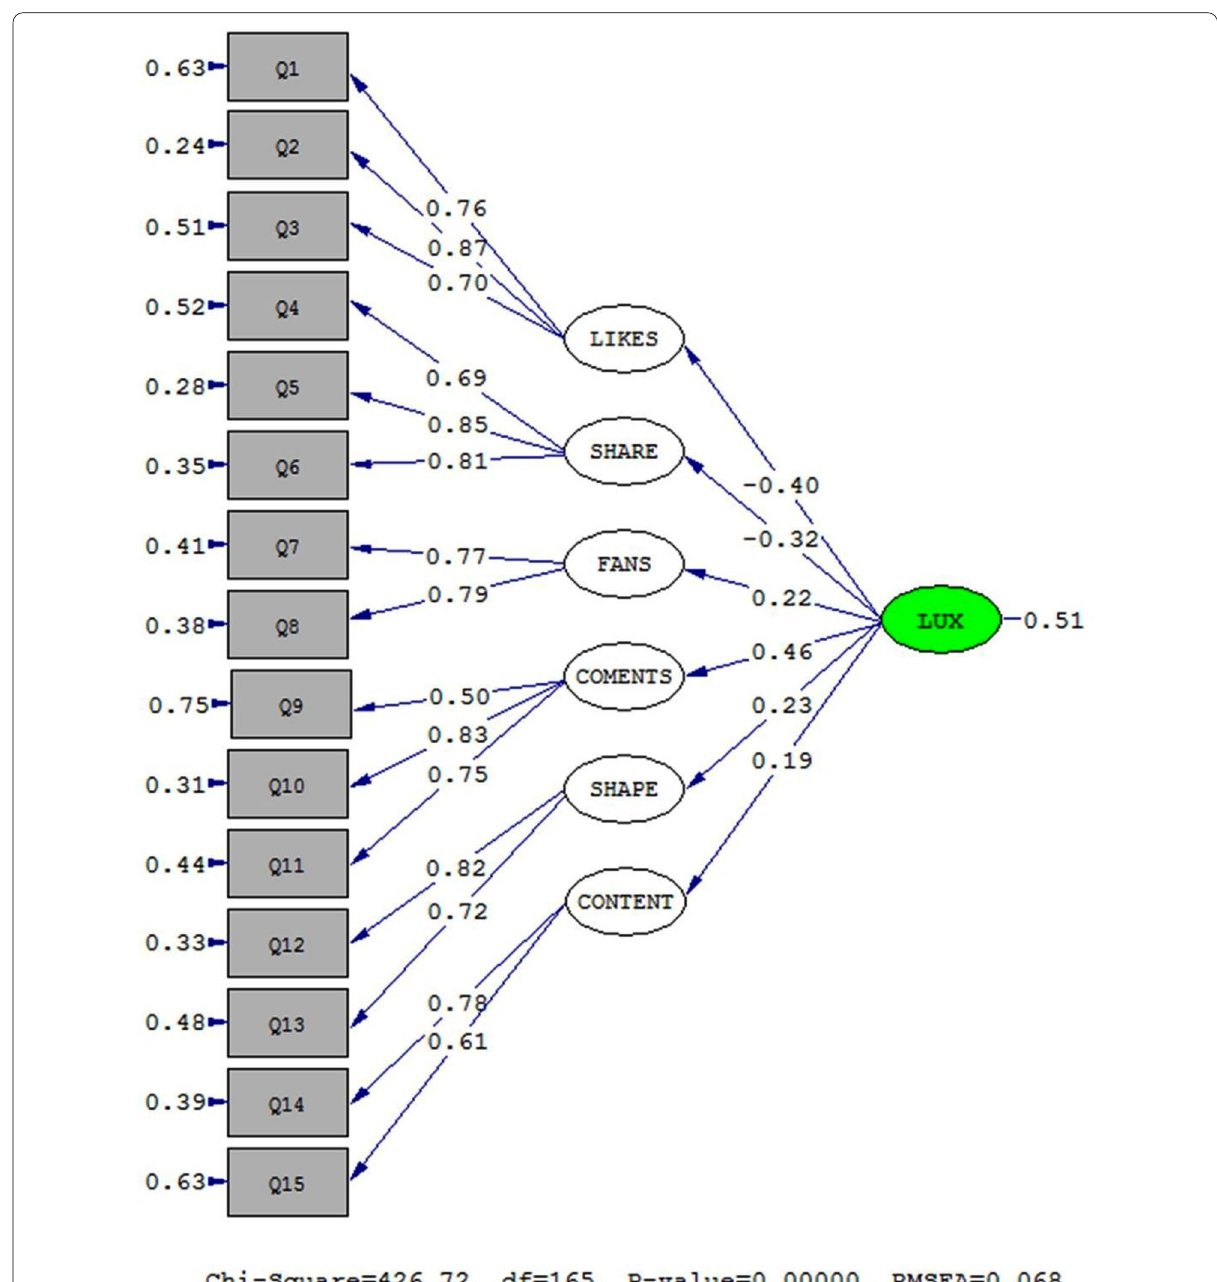
Fig. 5 Testing the conceptual model in the state of standardized